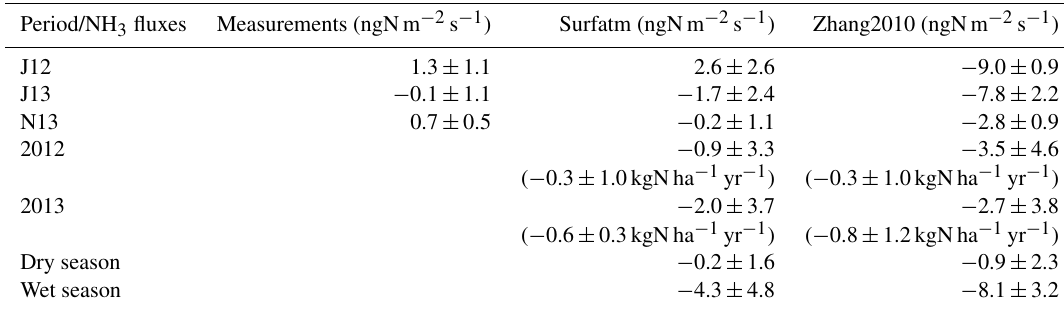
Figure 9. Daily NH 3 flux (ngNm − 2 s − 1 ) simulated by Surfatm (black line) and Zhang2010 (grey dashed line) and daily averaged NH 3 flux measurements during three field campaigns (red triangles). Error bars in red stand for standard deviation at the daily scale. Air humidity as a percentage (blue line). DS: dry season; WS: west season. Table 3. Averaged NH 3 fluxes for measurements and the Surfatm and Zhang2010 models during specific periods. Measurements are available during the three field campaigns and not at the annual or seasonal